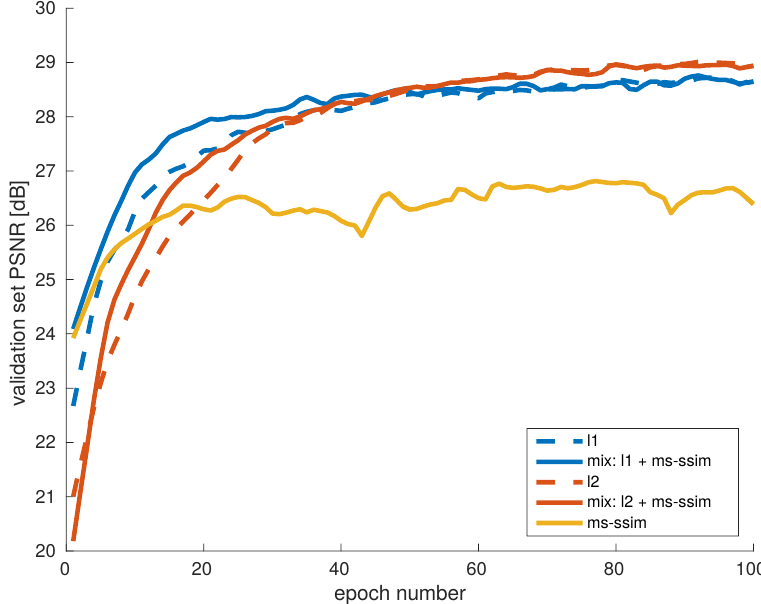
Figure 9. Evaluation of different loss functions for training a demosaicing network. A combined loss improves training speed, compared to minimizing each metric individually. MS-SSIM is sensitive to image details and can converge to a subpoptimal solution with respect to